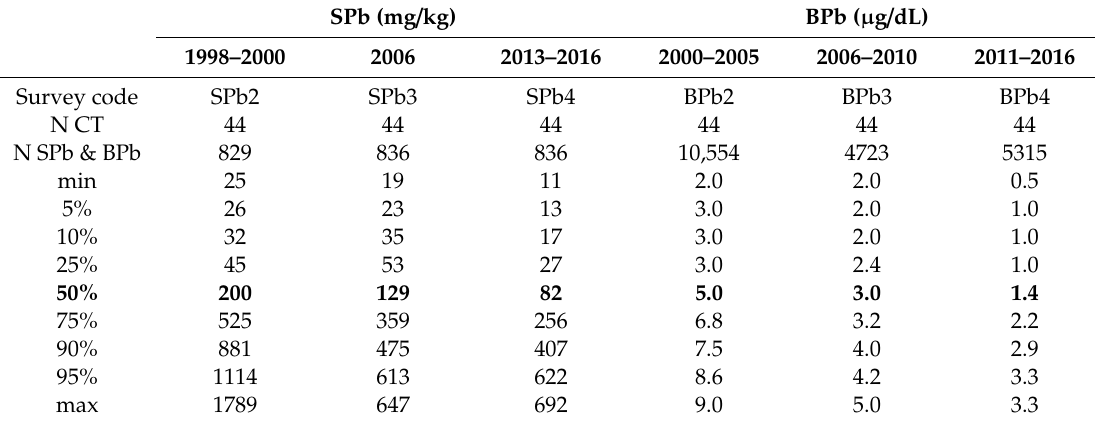
Table 1. Percentiles of soil Pb (SPb) and children’s blood Pb (BPb) median results of 44 residential communities in metropolitan New Orleans. Note the continuous 50% (bold) SPb decreases (left